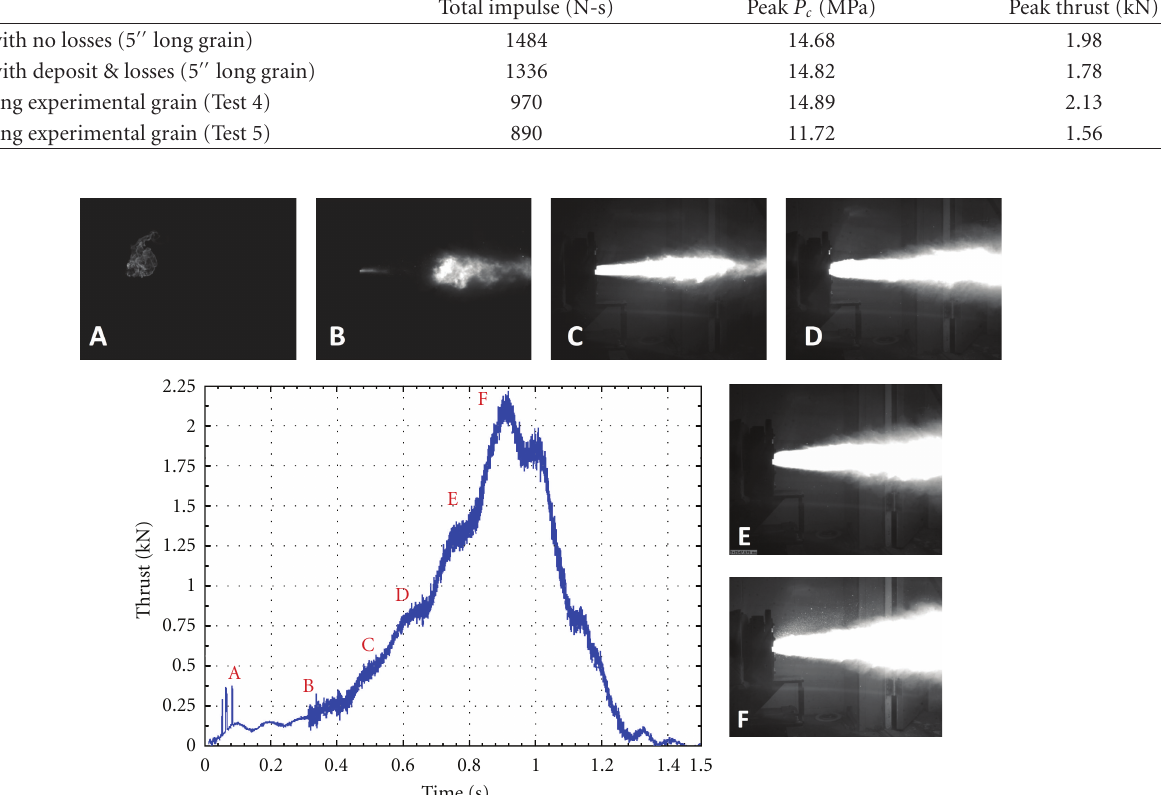
Figure 6: Thrust profile of Test 4 and corresponding plume images recorded by the high-speed